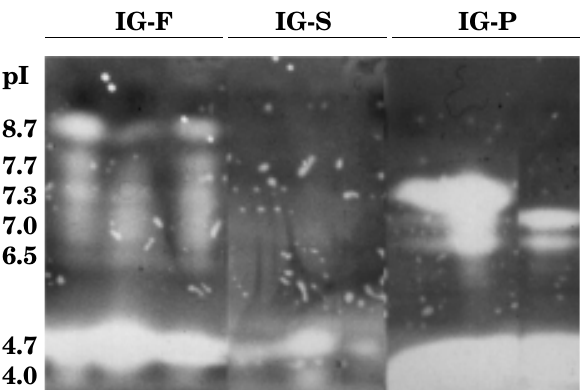
Fig. 4. Isoelectric focusing (IEF) zymograms of polyga- lacturonase (PG) produced by different isolates of the intersterile groups (IGs) F, S and P of Heterobasidion annosum on day 16 from inoculation in a liquid medi- um containing pectin as the sole carbon source. Sam- ples (2 ml of 50-fold concentrated culture filtrate) were separated by broad-range analytical IEF. PG activity, detected by the activity stain overlay technique at pH 5, appear as white bands. The pI values of bands are indicated on the left.